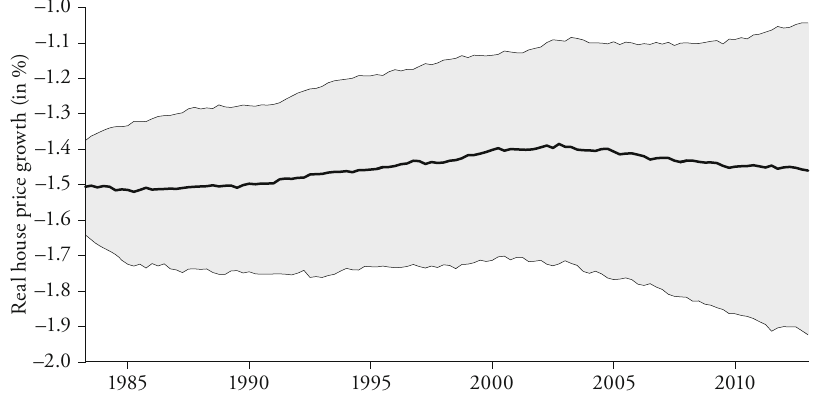
Figure 7: Effect (after 8 quarters) of House Price Responses to a Shock on Population Adjusted Housing Supply